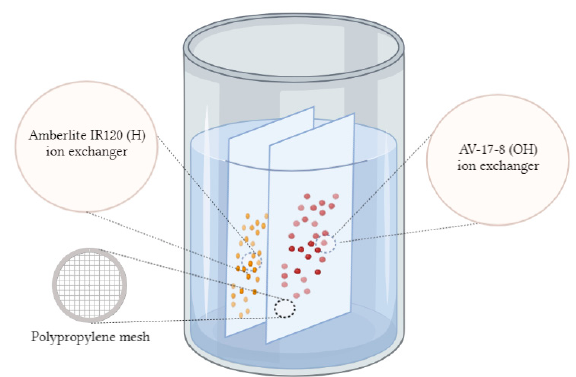
Figure 1. Illustration of the activation process of the interpolymer system “Amberlite IR120:AV-17-8” (X:Y) by remote interaction in the aqueous solution.